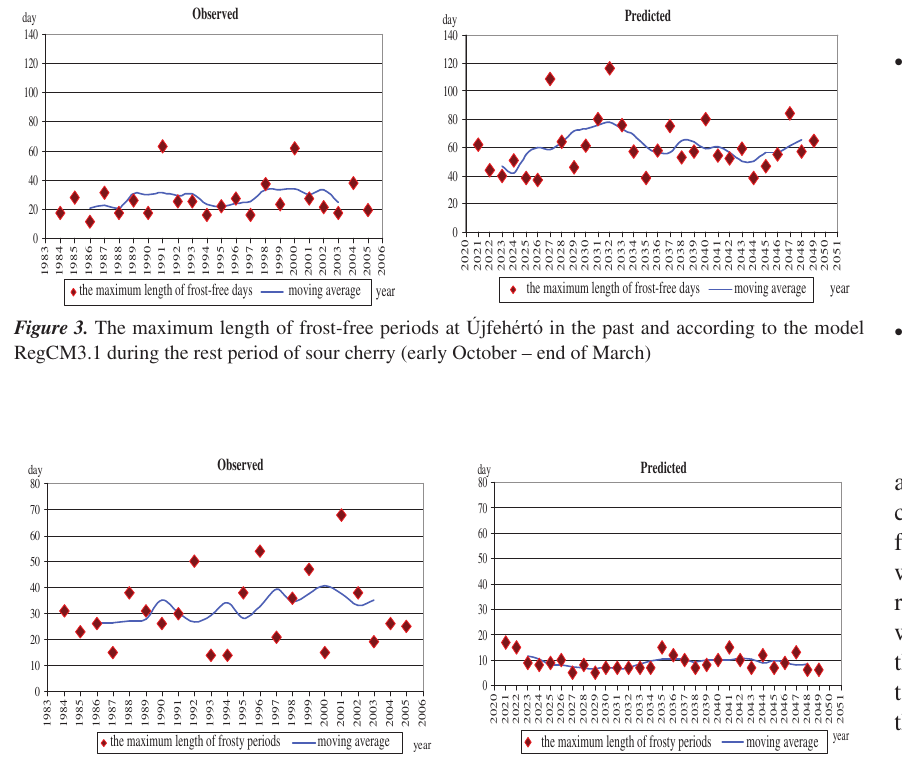
Figure 4. The maximum length of frosty periods at Újfehértó during the rest period of sour cherry (early October-end of